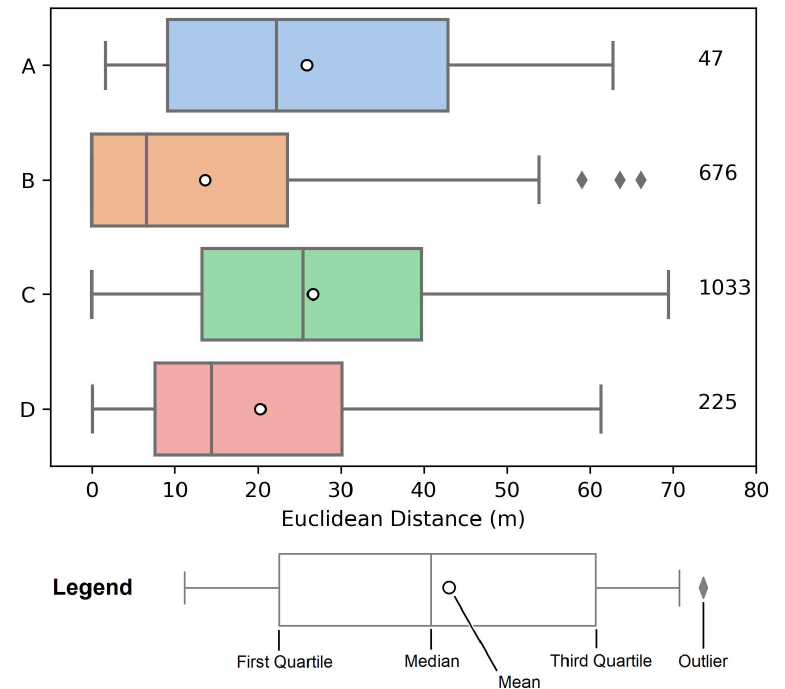
Figure 3. Distribution of spatial error based on euclidean distance between corresponding points in four data sources A to D ( D eval ) and D ref . Numbers on right of distribution indicate number of corresponding points in each data